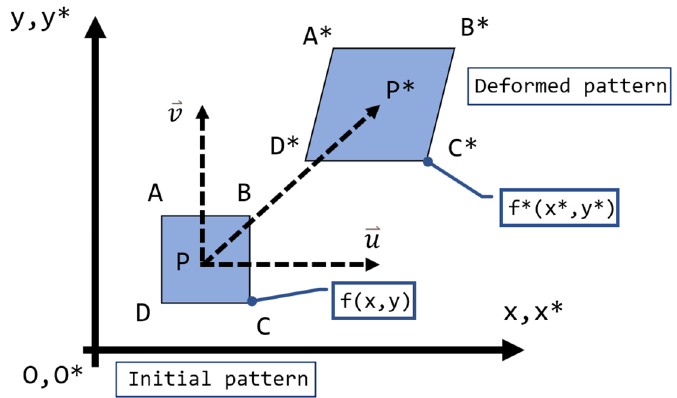
Figure 4. The digital image correlation principle.